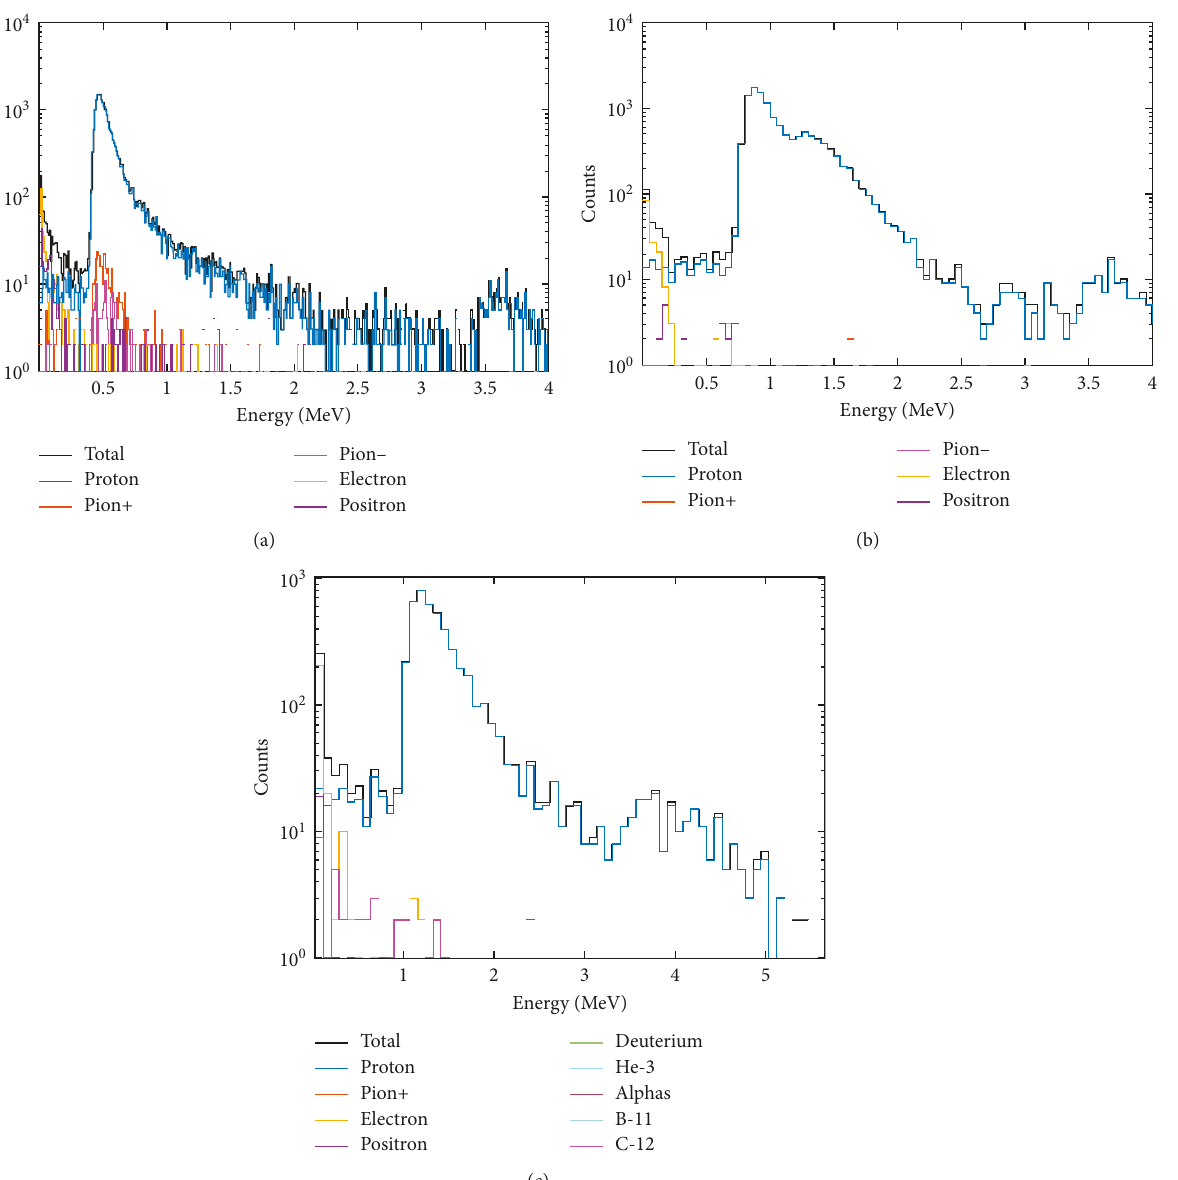
Figure 6: Interacted particles with the diamond sensor A for proton beams: (a) 2.5 GeV, (b) 800 MeV, and (c)